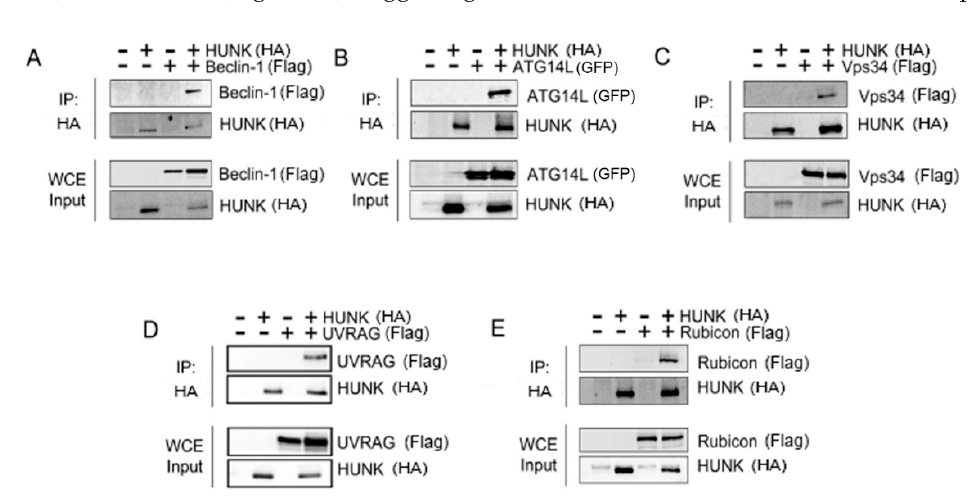
Figure 2. HUNK binds the Beclin-1 complex members. HA-HUNK and either ( A ) Flag-Beclin-1, ( B ) GFP-Atg14L, ( C ) Flag-Vps34, ( D ) Flag-UVRAG, or ( E ) Flag-Rubicon were co-transfected into 293T cells. HUNK was immunoprecipitated and binding of individual proteins was assessed via immunoblotting for each Beclin-1 complex member. Each member of the Beclin complex co-